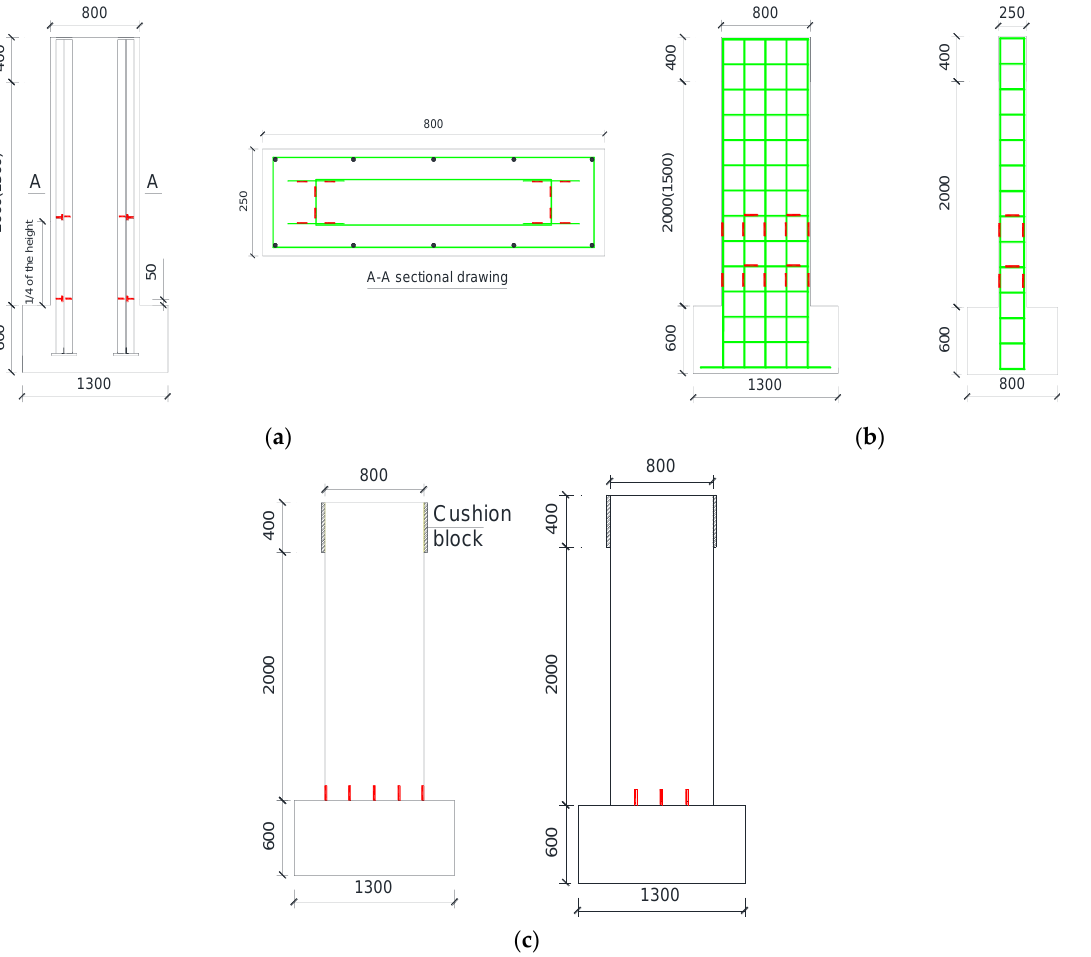
Figure 3. The Layout of the Strain Gauges. ( a ) H-shape steel. ( b ) Reinforcement. ( c ) Concrete.